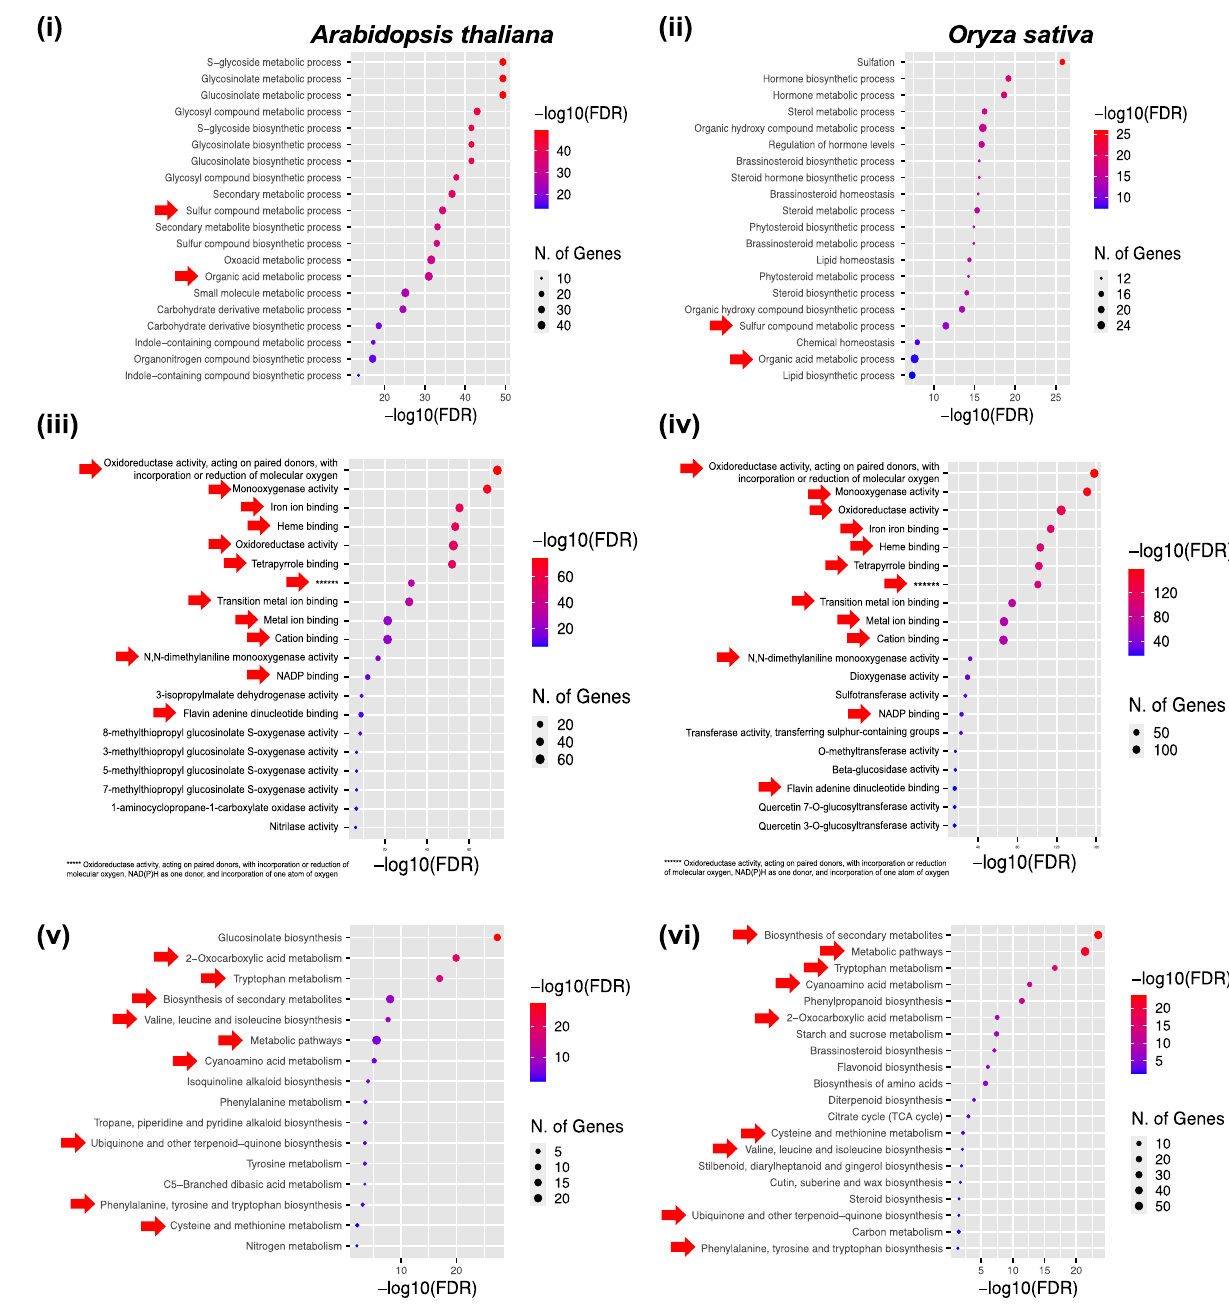
Figure 6. Gene ontology (GO) and pathway enrichment analysis. The bubble plot represents the top 20 significantly enriched terms of the Arabidopsis- rice homologous SCC-encoding geens. The GO terms are presented in (i-ii) biological process and (iii-iv) molecular functions whereas the KEGG pathways are presented in (v-vii). Red arrows represent the terms shared among the Arabidopsis- rice orthologous genes. The results are visualized at P < 0.05 using ShinyGO v0.75 (http:// bioin forma tics. sdsta te. edu/